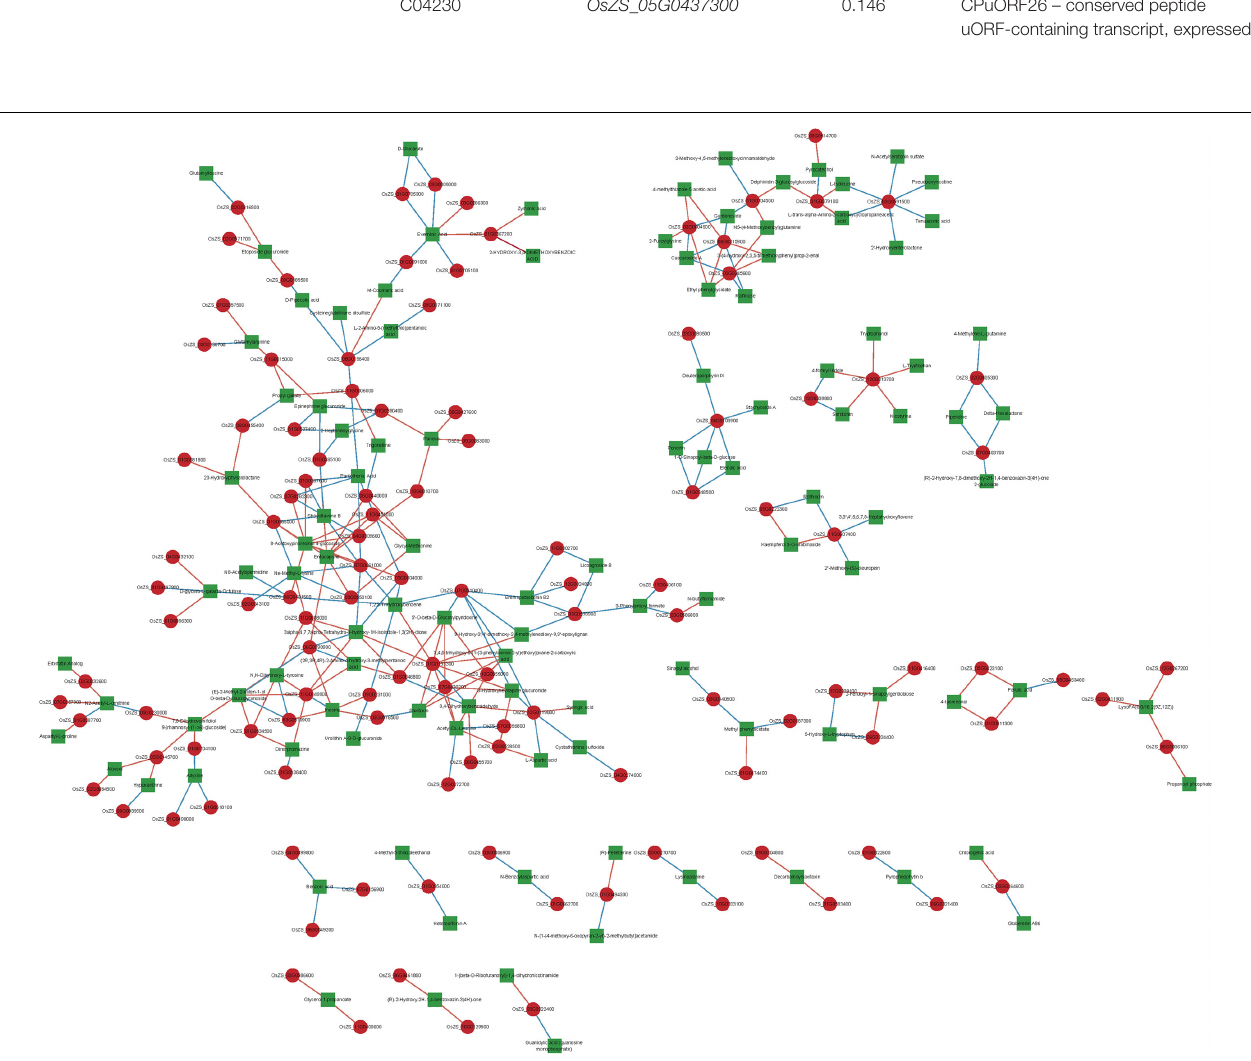
FIGURE 7 | Gene-metabolites associated network analysis. Each node in the figure represents a gene/metabolite, the red square dot represents the gene, the green square dot indicates the metabolites, the size of the node indicates the point connectivity; each connection indicates the interaction between the gene and the metabolites, the red line represents the positive correlation, the blue line indicates the negative correlation, the width of the connection indicates the size of the correlation coefficient, the larger the wider the correlation line.